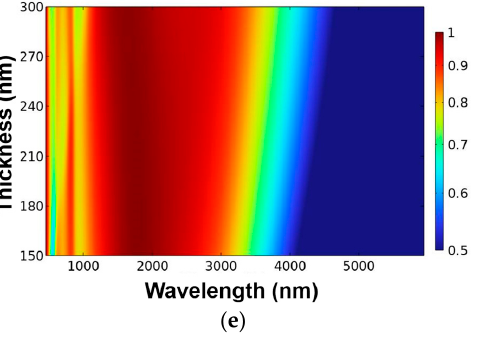
Figure 2. Effects of different thicknesses on the absorptivity of each layer of the designed absorber ( a ) anti-reflection TiO 2 layer (t1), ( b ) upper Ti layer (t2), ( c ) PNIPAAm layer (t3), ( d ) lower Ti layer (t4), and ( e ) SiO 2 dielectric layer (t5).